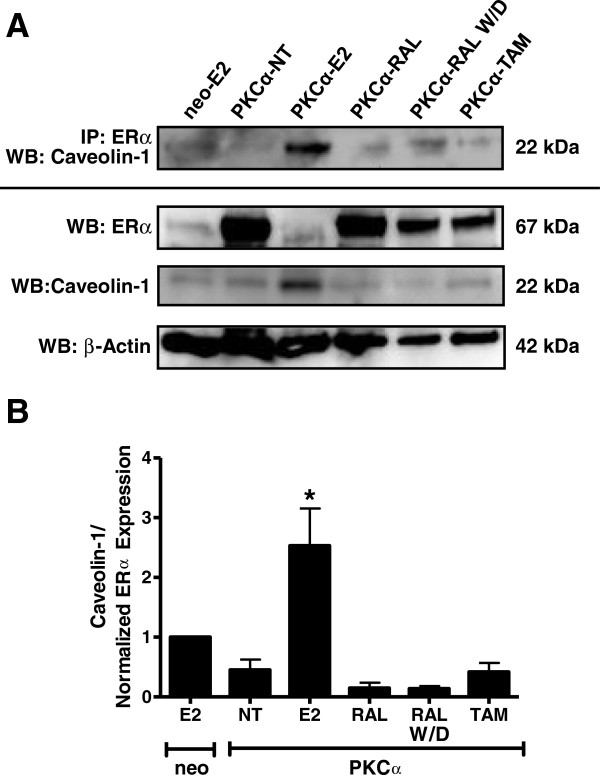
ERα/caveolin-1 complex formation in response to E2, TAM and RAL treatment in T47D:A18/PKCα tumors. A. Representative western blot of co-IP experiments in T47D:A18/PKCα and T47D:A18/neo tumor extracts as detailed in materials and methods. B. Densitometric quantification of three co-IP experiments from three independent tumors for each group. Error bars represent SEM. *, P < 0.05 compared to all groups determined by one-way ANOVA followed by Bonferroni’s post-test.